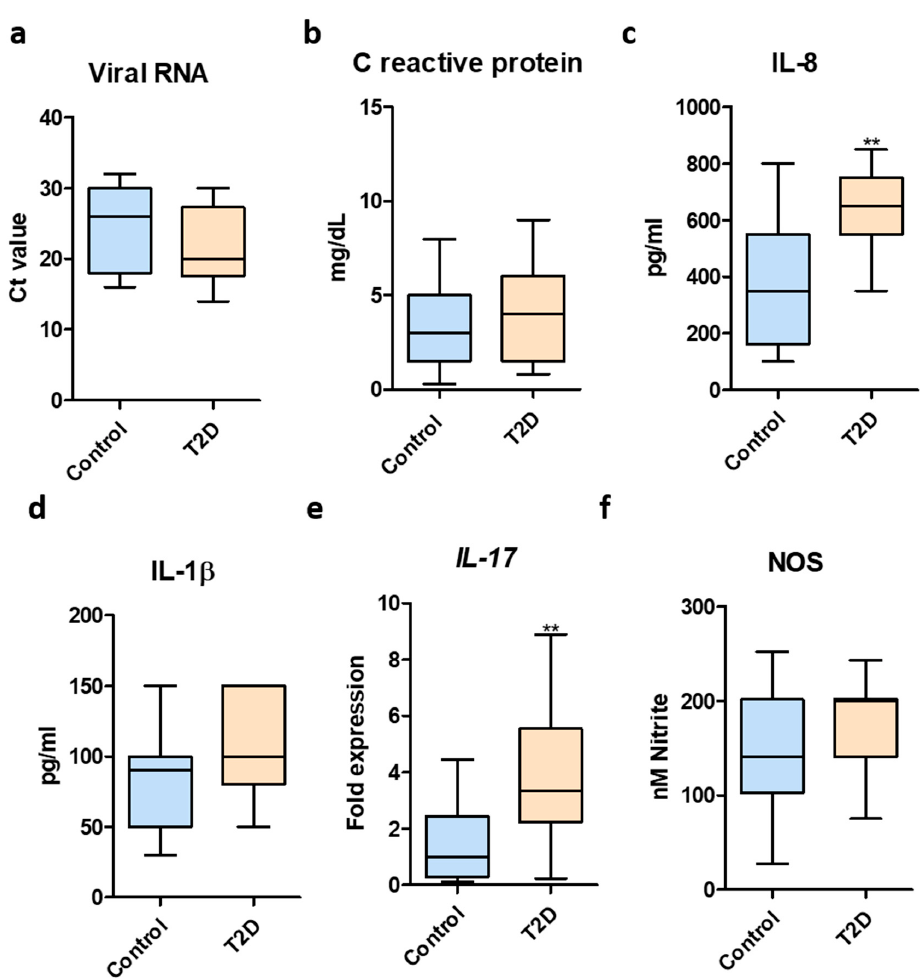
Figure 1. Inflammatory markers in T2D after SARS-CoV-2 infection. ( a ) SARS-CoV-2 RNA levels in healthy controls and T2D patients—determined using RT PCR; ( b ) CRP quantification in serum samples from SARS-CoV-2-infected healthy controls and T2D patients; ( c ) IL-8 quantification in serum samples from SARS-CoV-2-infected healthy controls and T2D patients; ( d ) IL-1 β in serum samples from SARS-CoV-2-infected healthy controls and T2D patients; ( e ) IL-17 expression in total blood samples from SARS-CoV-2-infected healthy controls and T2D patients; ( f ) NOS quantification in serum samples from SARS-CoV-2-infected healthy controls and T2D patients. Statistical analyses performed using Unpaired t -test with Welch’s correction. **, p < 0.01.